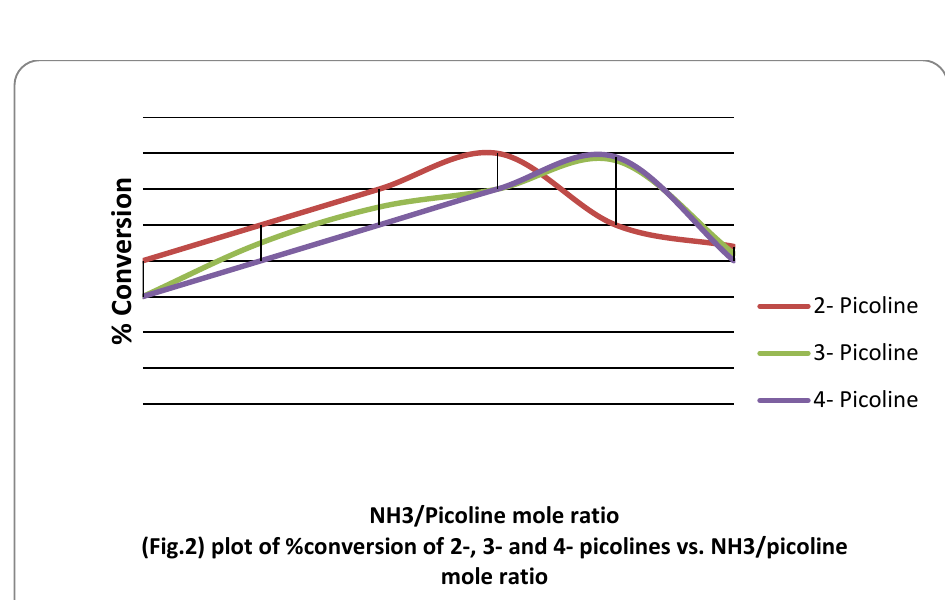
(Fig. 1) plot of %conversion of 2-,3- and 4-picolines vs.